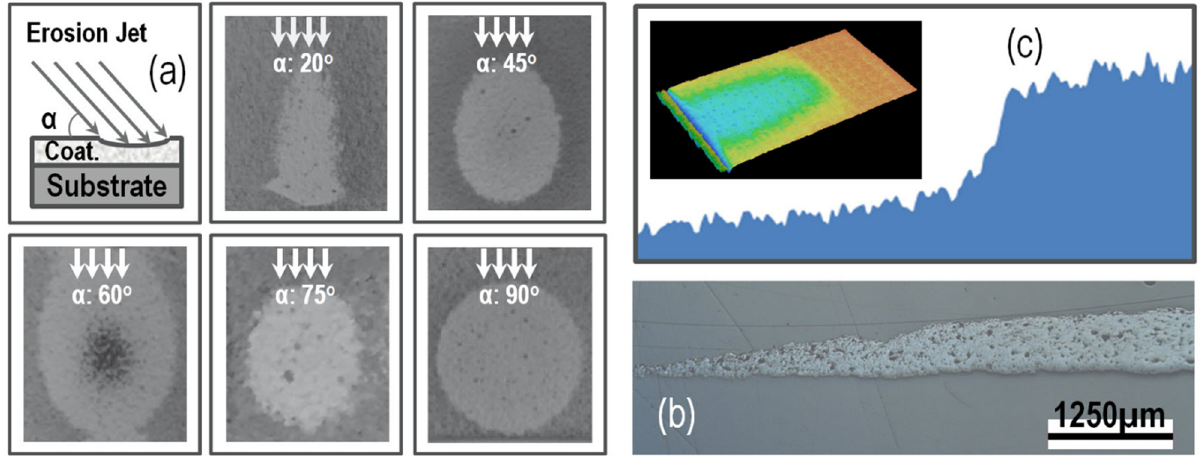
Figure 10. Surface photograph images of SPE erosion samples: ( a ) erosion scar marks on the dual- phase TBCs at different impinging angles; ( b ) cross-sectional images of the SPE-tested sample at an angle of 20°; ( c ) thickness profile for the eroded sample in ( b ).